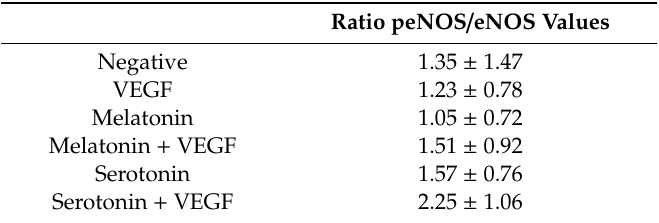
Table 2. Ratio peNOS / endothelial nitric oxide synthase (eNOS) values for melatonin and